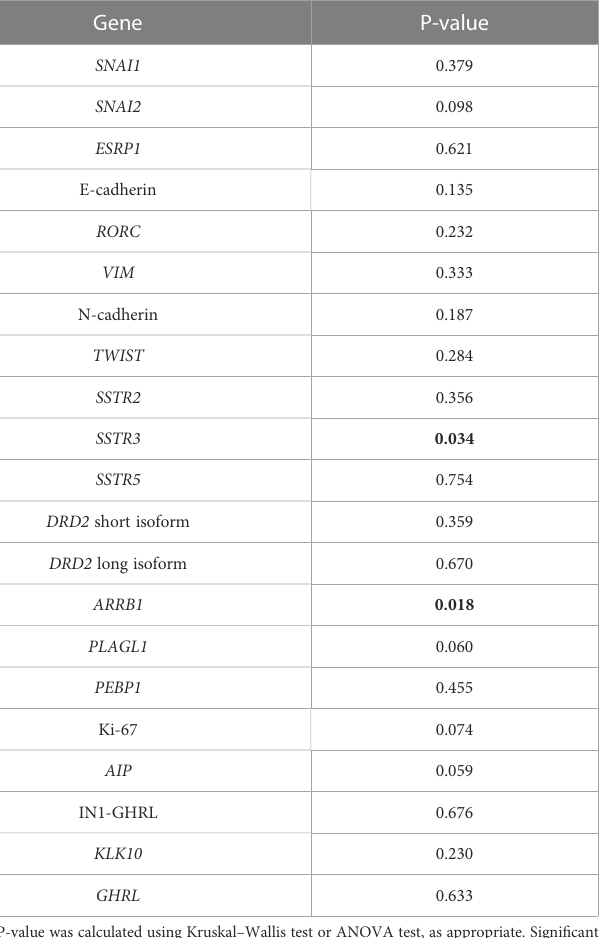
TABLE 5 Analysis of differences between the relative expression of each gene and the positive immunostaining for pituitary hormones. Gene